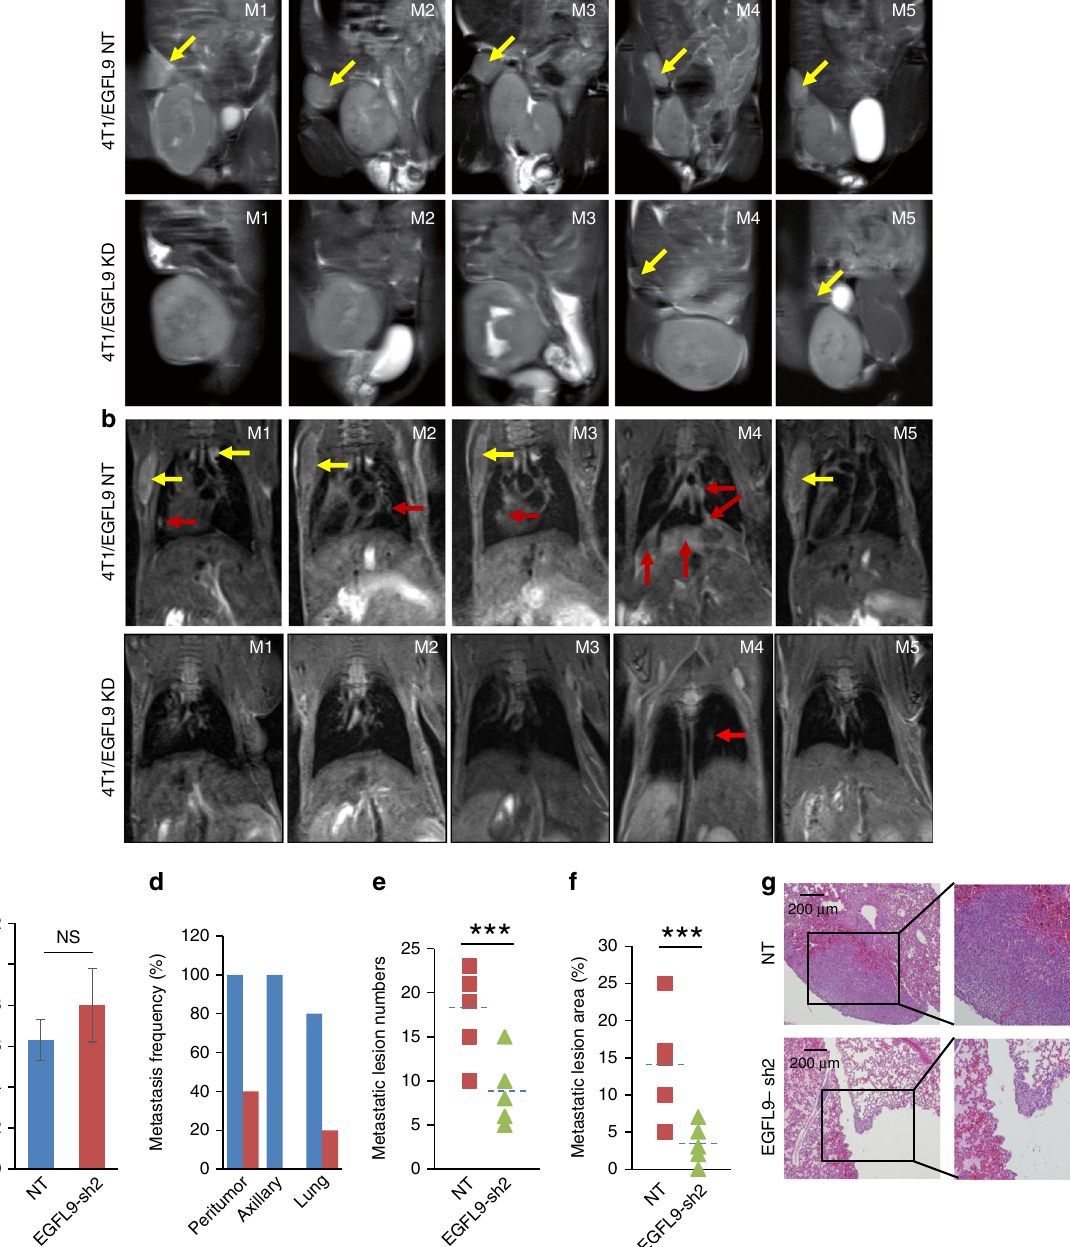
Fig. 4 Knockdown of EGFL9 inhibits distant tumor metastasis in vivo. a MRI examination identi fi ed peritumor lymph nodes metastasis in 4T1/NT injected mice (bottom panels), but not in 4T1/EGFL9-sh2 injected mice (top panels). Five cases of 4T1 tumor xenograft mouse model were shown. Yellow arrow showed the peritumor localization in each case. b MRI examination identi fi ed axillary lymph nodes and lung metastasis in 4T1/EGFL9-NT-injected mice (bottom panels), but not in 4T1/EGFL9-sh2-injected mice (top panels). Five cases of 4T1 tumor xenograft mouse model were shown. Yellow arrow shows the localization of axillary lymph nodes metastasis and red arrow showed the lung metastasis in each case. c Quantitative tumor size summary by MRI detection. No signi fi cant difference was observed in two groups of tumors (NS, P > 0.05). Each bar represents the mean ± SEM (standard error of the mean, n = 5). P value was determined by unpaired two-tailed t -test. d The frequencies of metastasis identi fi ed by MRI in peritumor lymph nodes (5/5 vs 2/ 5), axillary lymph nodes (5/5 vs 0/5), and lungs (4/5 vs 1/5) of BALB/c mice ( n = 5 in each group) with control 4T1 (blue bar) and 4T1/EGFL9-sh2 (red bar) cells. e Comparison of metastatic lesion numbers in two groups of tumors. Average metastatic lesion numbers from fi ve series sections were counted for each tumor. *** P < 0.001. f Comparison of metastasis lesion area in two groups of tumors. Relative metastatic lesion areas (tumor lesion/lung section) from sections with highest metastatic lesion number in each tumor were compared. *** P < 0.001. For both e and f panels, P values were determined by unpaired two-tailed t -test ( n = 5). g Representative H&E staining of lung sections from mice. IHC demonstrated signi fi cant metastatic lesions in NT (non- targeting shRNA)-transfected 4T1 cells (top panels) in comparison with EGFL9-sh2-transfected 4T1 (bottom panels). Magni fi cation: ×40 (left panels) and ×100 (right panels). Scale bar: 200 µ